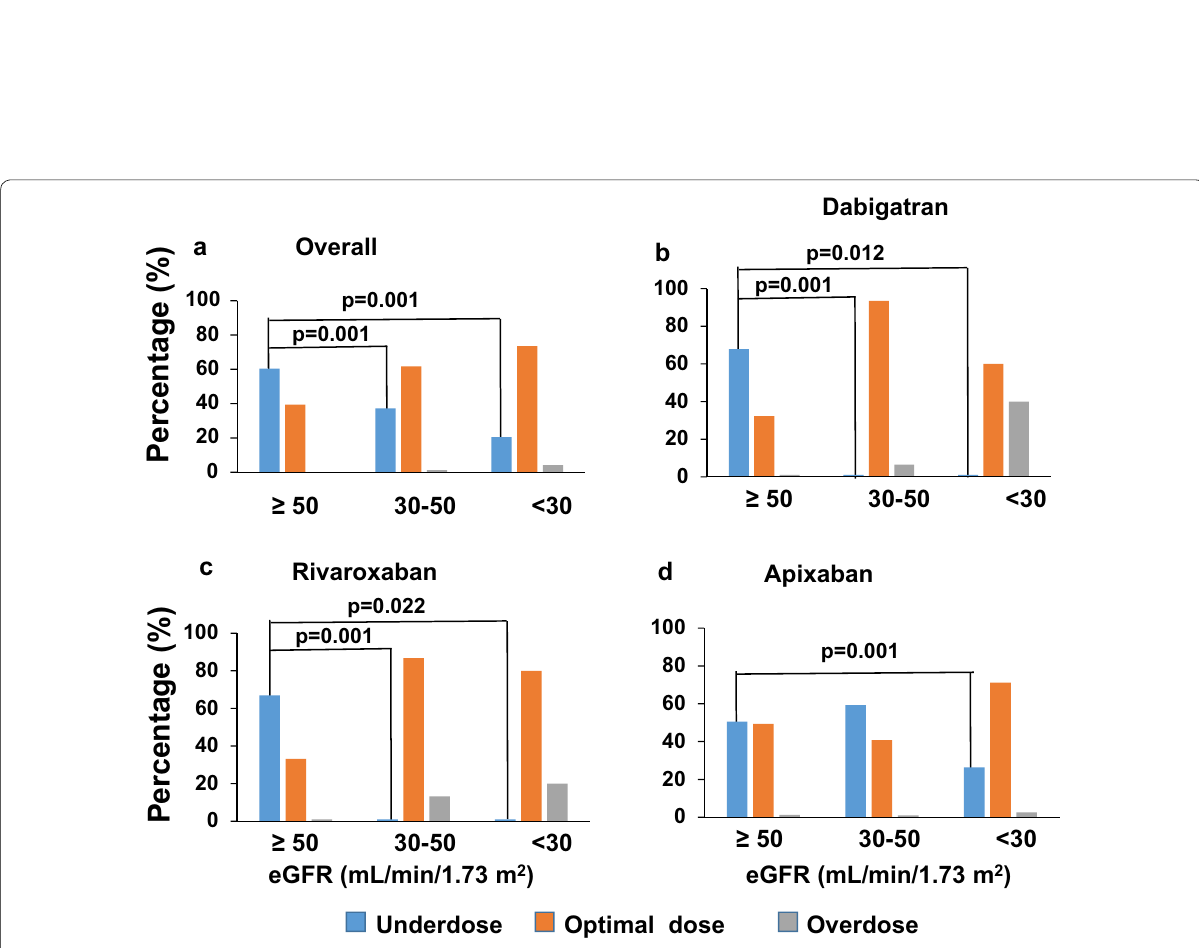
Fig. 5 Dosage of non‑vitamin K oral anticoagulants (NOACs) according to eGFR in patients with chronic kidney disease. a Overall, b dabigatran, c rivaroxaban, d apixaban. In the overall NOACs, the dabigatran and rivaroxaban underdose rates were lower in patients with eGFR from 50 to 30 and < 30 mL min − 1 1.73 m − 2 than in those with eGFR 50 mL min − 1 1.73 m − 2 . eGFR, estimated glomerular filtration ≥